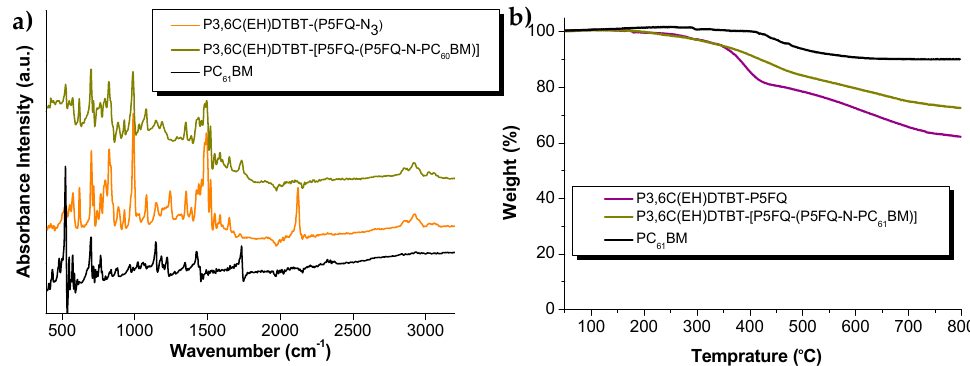
Figure 11. ( a ) ATR spectra of P3,6C(EH)DTBT-P5FQ, P3,6C(EH)DTBT-(P5FQ-N 3 ) and P3,6C(EH)DTBT-(P5FQ-(P5FQ-N-PC 61 BM)); ( b ) TGA thermograms of P3,6C(EH)DTBT-P5FQ, P3,6C(EH)DTBT-(P5FQ-(P5FQ-N-PC 61 BM) and PC 61 BM.